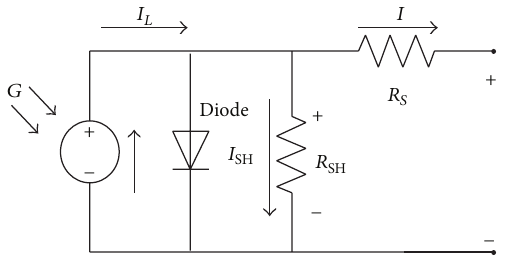
Figure 1: Equivalent circuit of a PV cell.